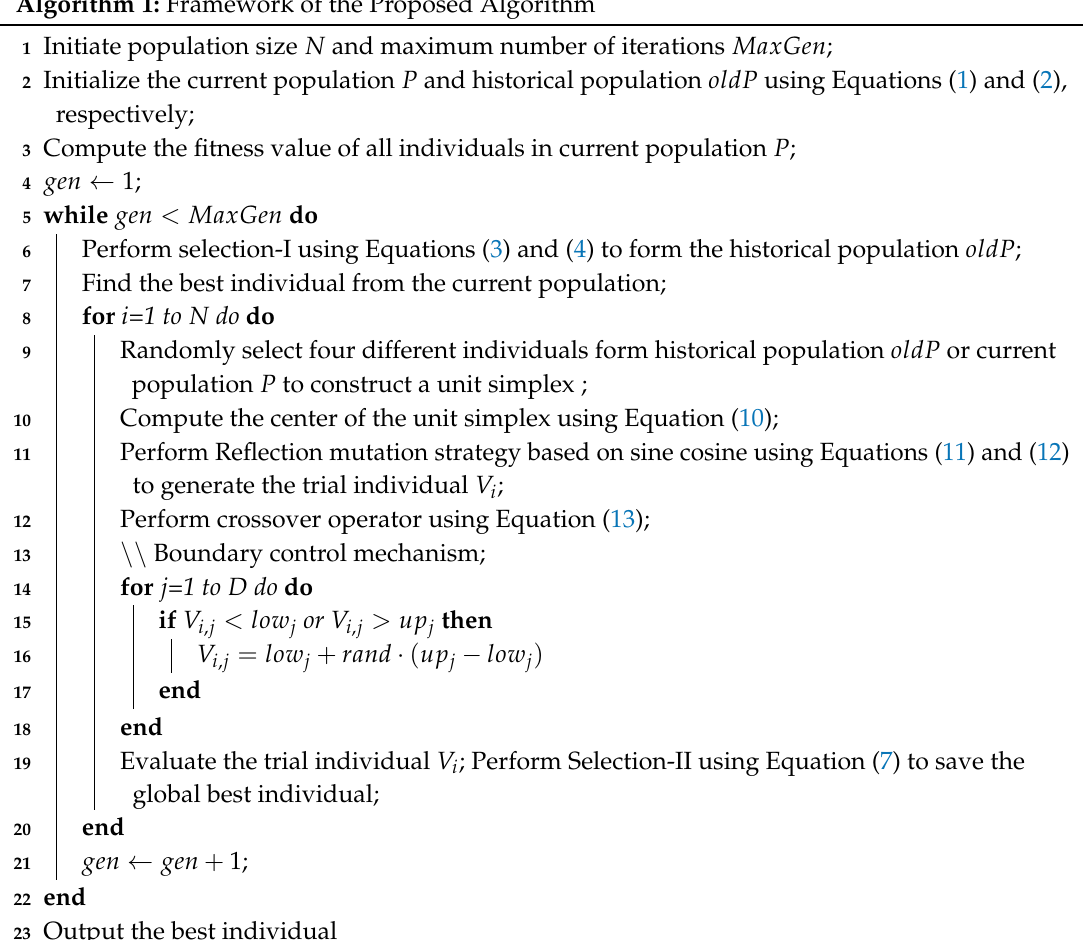
Algorithm 1: Framework of the Proposed